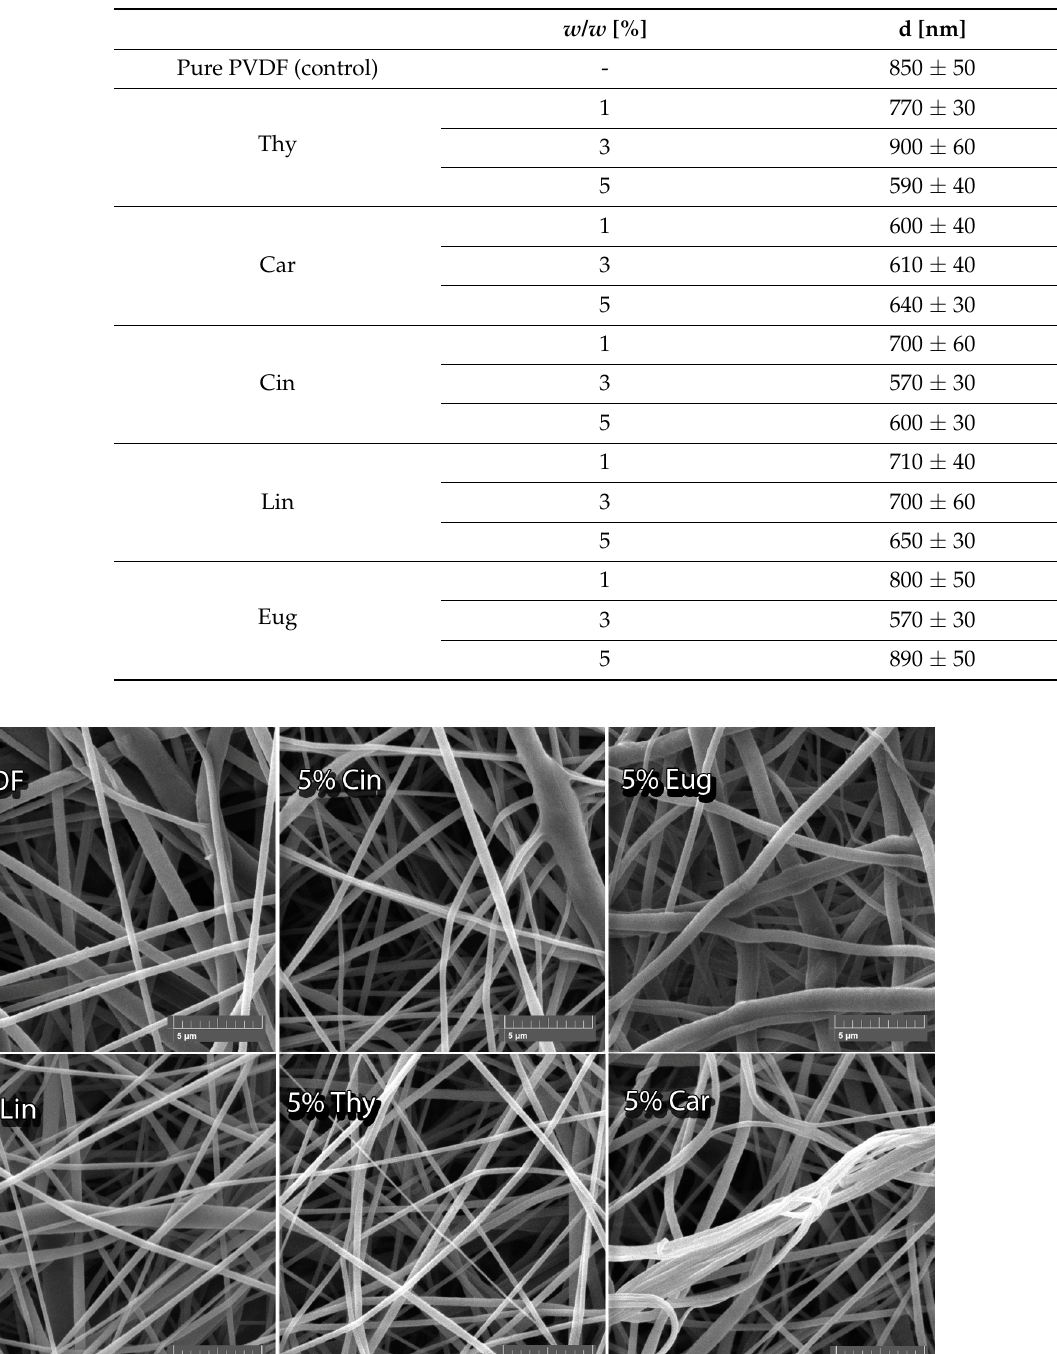
Table 3. Diameters of PVDF nanofibers.